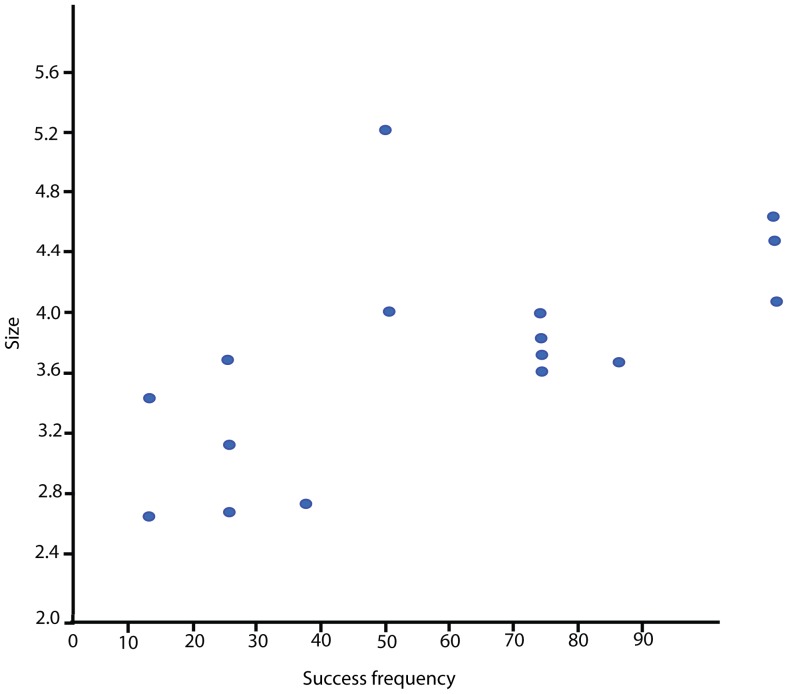
Bivariate plot showing the relationship between overall cut-mark size and the success rates of participants diagnosing modifications correctly.